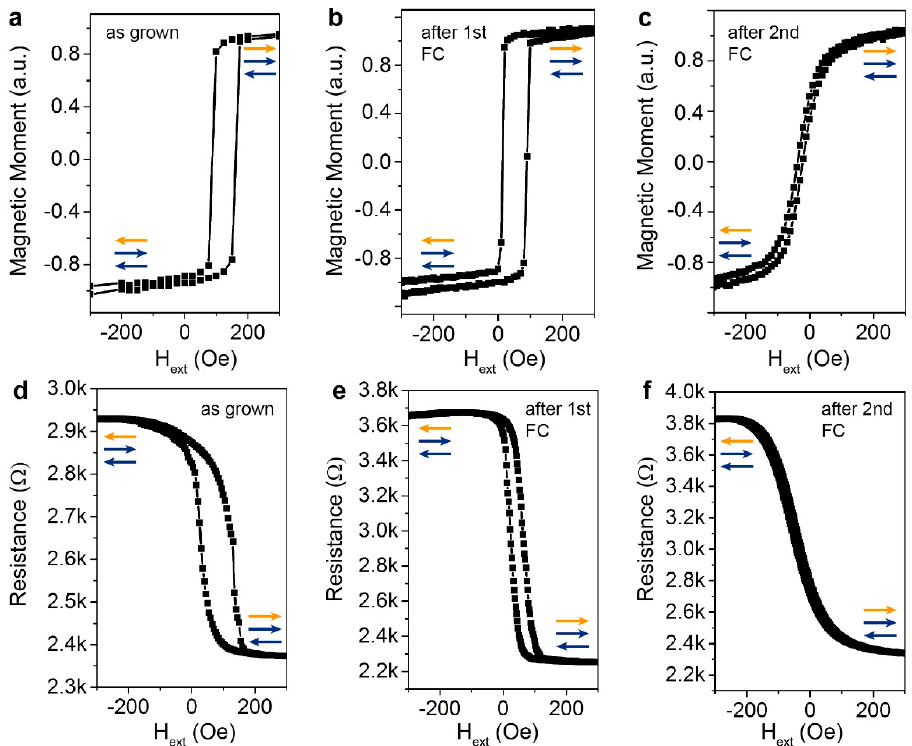
Figure 5. Upper panels: M-H loops measured along the easy-axis of the bottom pinned layer of the sensor ( a ) as grown; ( b ) after the first field cooling and ( c ) after the second field cooling. Lower panels: TMR curves of the sensor ( d ) as grown; ( e ) after the first field cooling and ( f ) after the second field cooling.